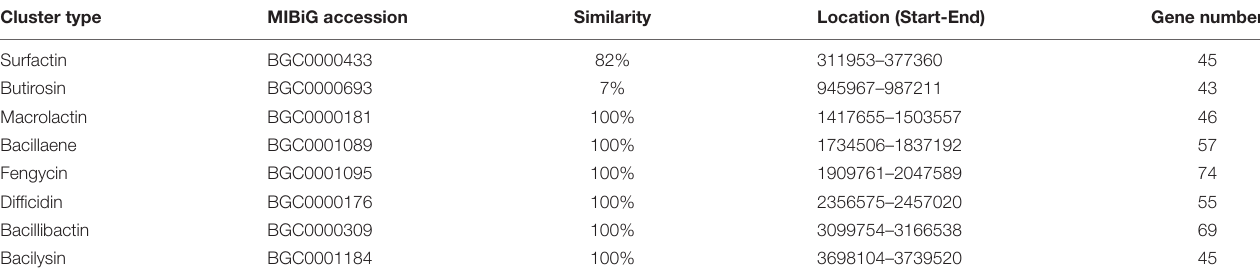
TABLE 1 | Secondary metabolites predicted by the antiSMASH analysis of Bacillus amyloliquefaciens